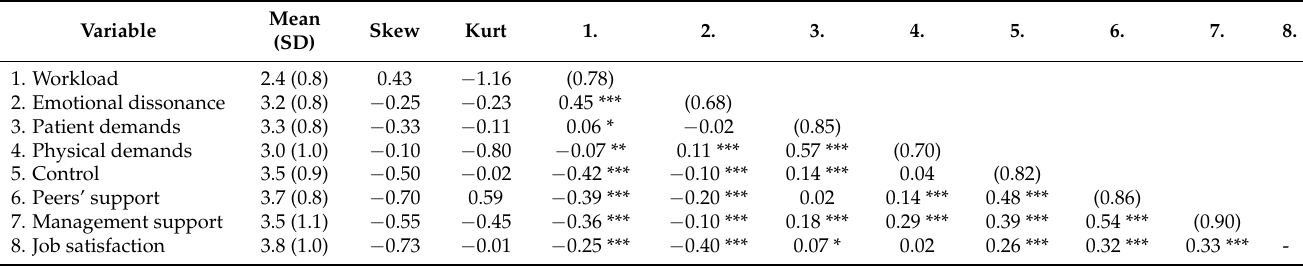
Table 1. Descriptive statistics for the study variables and ESEM factor score